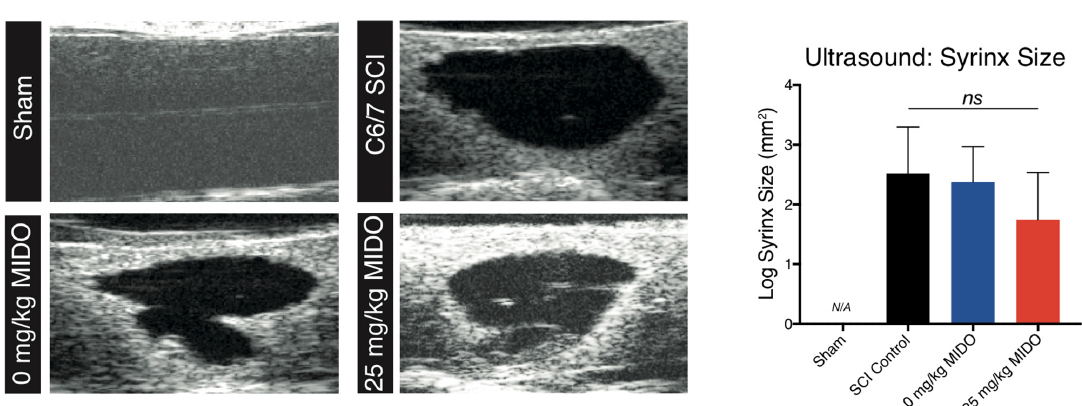
Figure 6. Ultrasonographical imaging of live spinal cord tissue revealed no significant changes in syrinx volume in the 25 mg/kg midostaurin group. Representative in vivo very high-resolution ultrasound imaging in B-Mode (11 × 7 mm) shown in sham, SCI control, 0 mg/kg midostaurin, and 25 mg/kg midostaurin cohorts (8 weeks post-surgery). No cavitation was visible in the sham animals. The graph represents ultrasonographical volume quantification ( n = 5 per cohort), as assessed with one-way ANOVA. Data are presented as mean ± SEM values. ns : not significant.